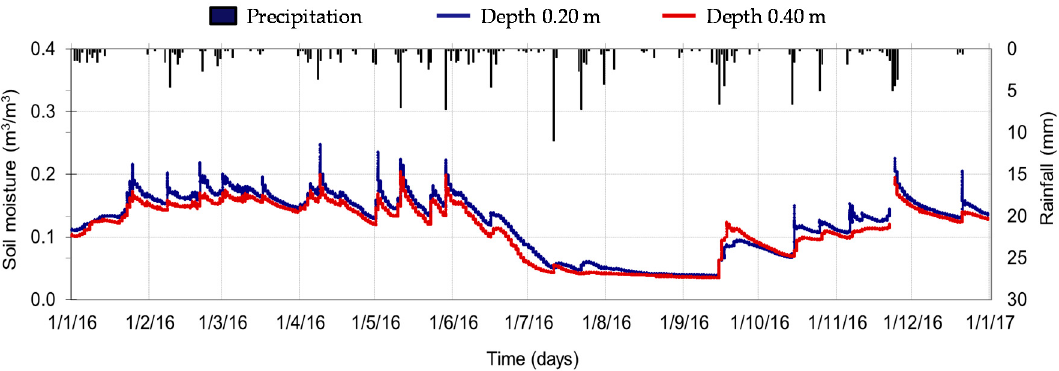
Figure 14. Cogne site, January–December 2016. Precipitation and soil moisture measured at 0.20 and 0.40 m depths.